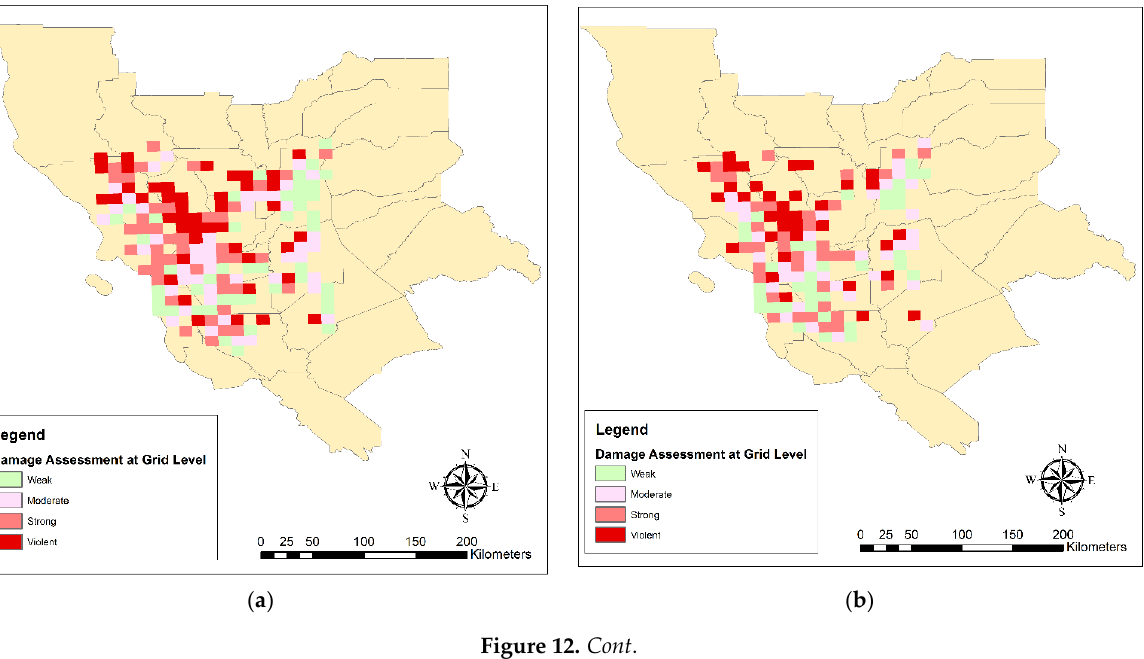
( c ) Figure 12. The estimated damage map from ( a ) Naive Bayes, ( b ) SVM, and ( c ) deep learning algorithms at the 10 × 10 km grids scale. 5.4. Damage Validation In this section, the estimated damage maps from each of the Naive, SVM, and deep learning algorithms were validated using the official damage map at three county, city, and 10 by 10 km grids scales. The official damage map, which was computed based on the FEMA HAZUS loss model, is shown at the three, county, city, and 10 by 10 km grid, scales in Figure 13 .